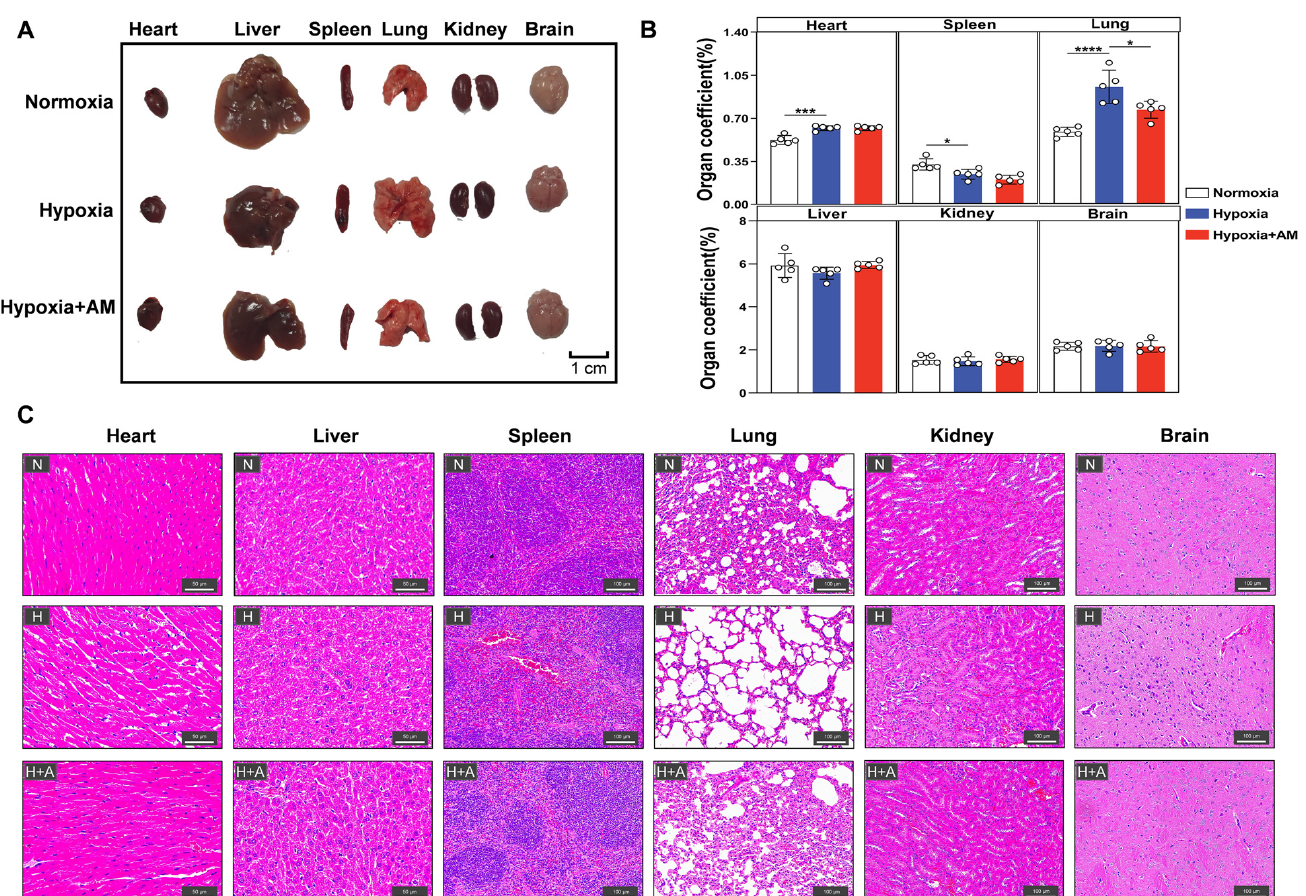
Figure 9. AM alleviated inflammatory in organs of HAPC mice. ( A – C ) Organ samples from mice 3 weeks after various treatments ( A ), organ indices ( B ), and organ H&E staining ( C ). N, normoxia; H, hypoxia; H + Q, hypoxia + AM. 20× (scale bar = 100 μ m), 40× (scale bar = 50 μ m). n = 5. * p < 0.05; *** p < 0.001; **** p < 0.0001. Compared with the Hypoxic group.